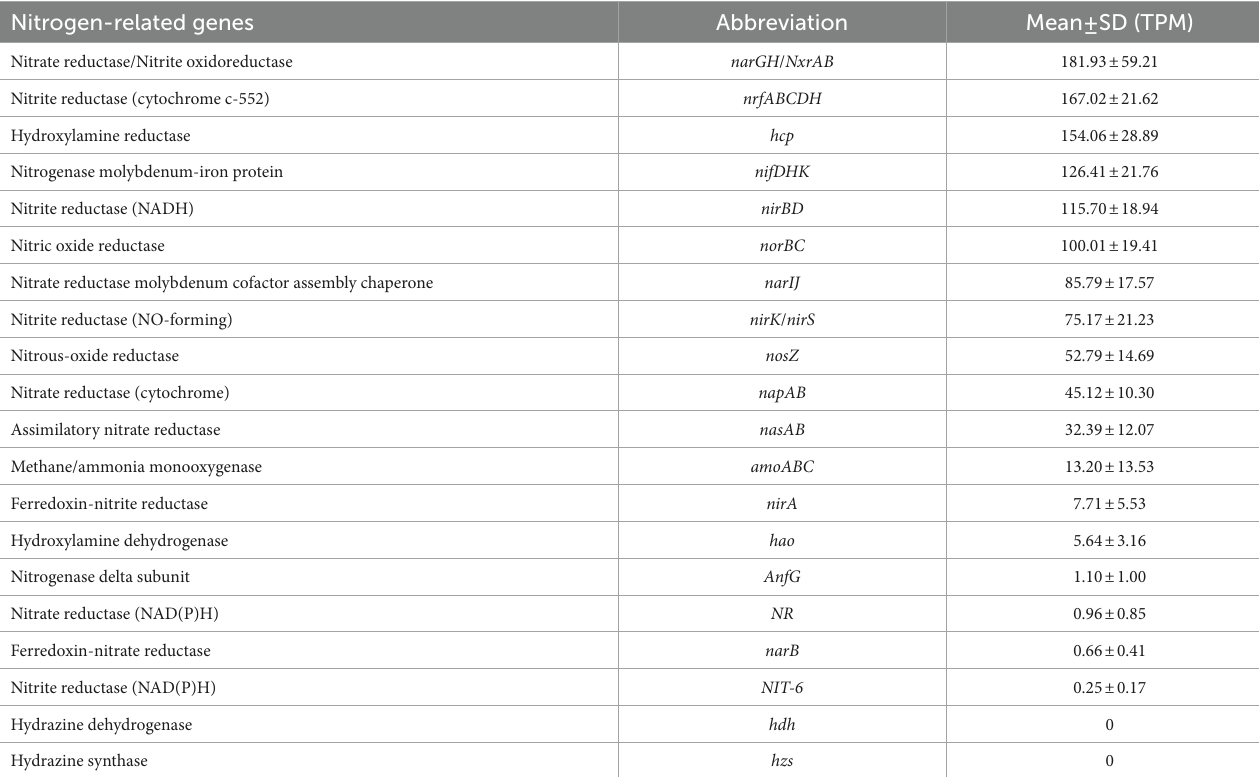
TABLE 3 Abundance of the nitrogen-related genes within 36 metagenomes. Nitrogen-related